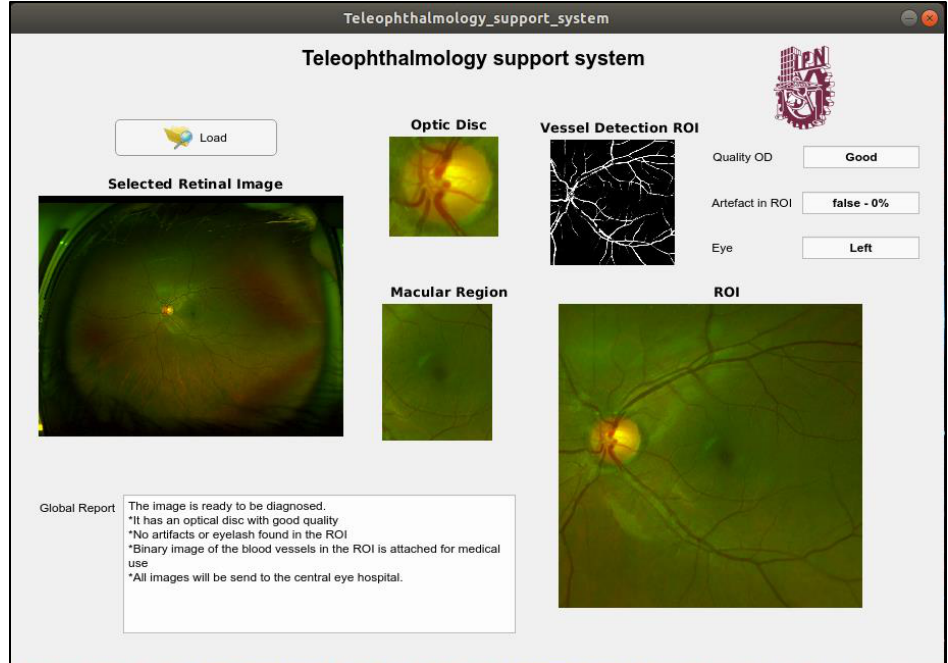
Figure 16. An example of output of the support system when the input image is good quality.